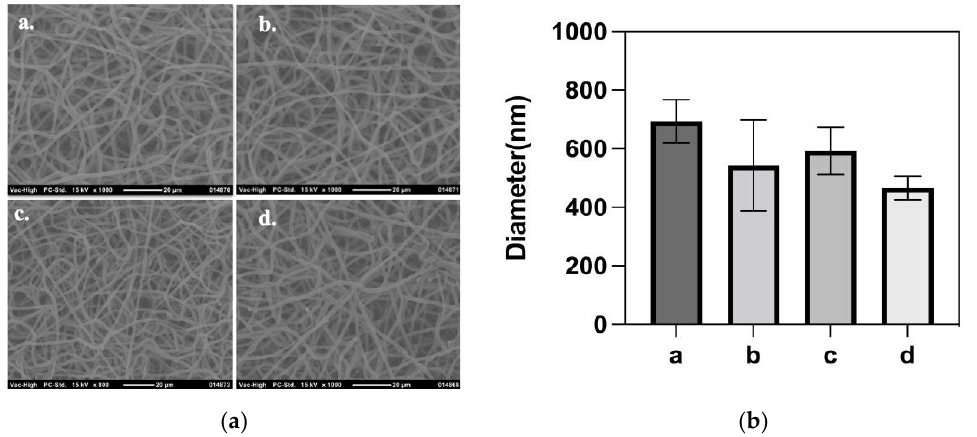
Figure 4. Nanofiber morphology and diameter under SEM. ( a ) SEM images of PCL-NFM; ( b ) average diameters of NFM. a . Blank PCL-NFM; b . 17AAG-NFM; c . TMZ-NFM; d . 17AAG+TMZ — NFM.